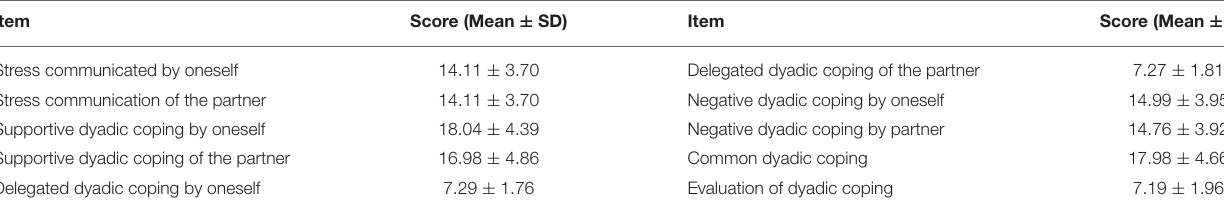
TABLE 2 | The scores of different dimensions of infertile women perception ( n = 482). Item